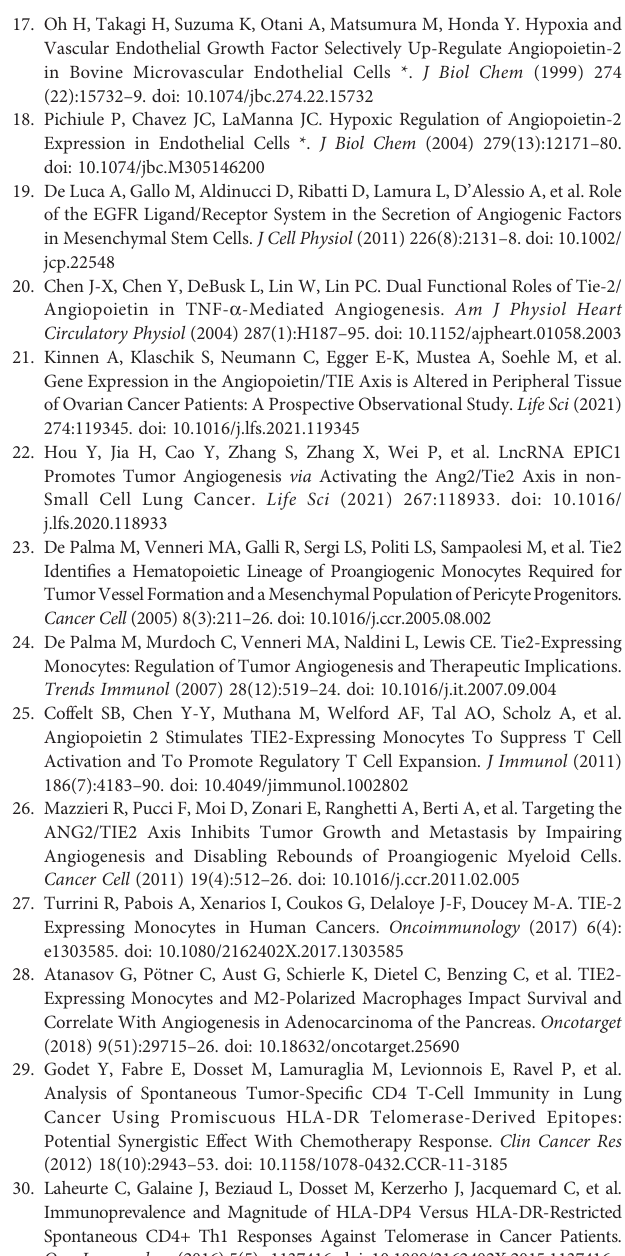
Supplementary Figure 3 | Immune suppressive factors of TIE-2 + M-MDSC. (A) MFI expression of different proteins (PD-L1, CD39, CD73, Arg1, TGF- b , IL-10, iNOS and COX2) studied in TIE-2 + M-MDSC and in TIE-2 neg M-MDSC after or not exposition to ANGPT2. (B) mRNA expression of different gene (TIE-2, CD73, Arg1, IL-10, STAT3 and CD39) were analyzed by RT-qPCR in TIE-2 High and TIE-2 Low M- MDSC and the fold change after ANGPT2 exposition was calculated. Supplementary Figure 4 | Effect of ANGPT2/TIE-2 signaling on M-MDSC on anti-tumor responses. PBMCs from melanoma patients with TIE2 High M-MDSC were stimulated with TERT class II peptides in presence or not of 300 ng/mL ANGPT2 and an IFN- g ELISpot assay was performed. IFN- g T cell responses, in left, one representative example of patient; in right, histograms from 6 patients respectively (Wilcoxon test **p< 0,01;